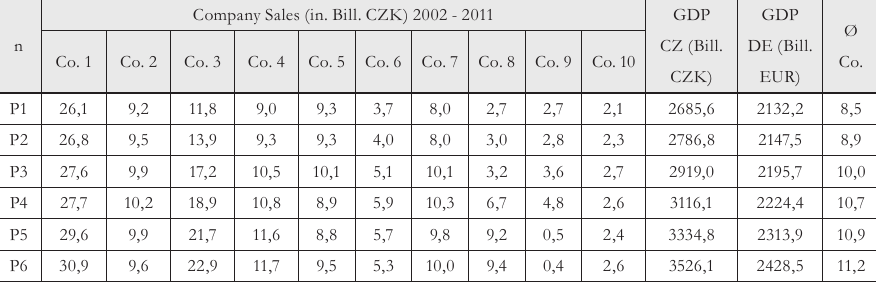
Tab. 2 – AutoSAP chosen companies RI Sales and CZ GDP. Source: own